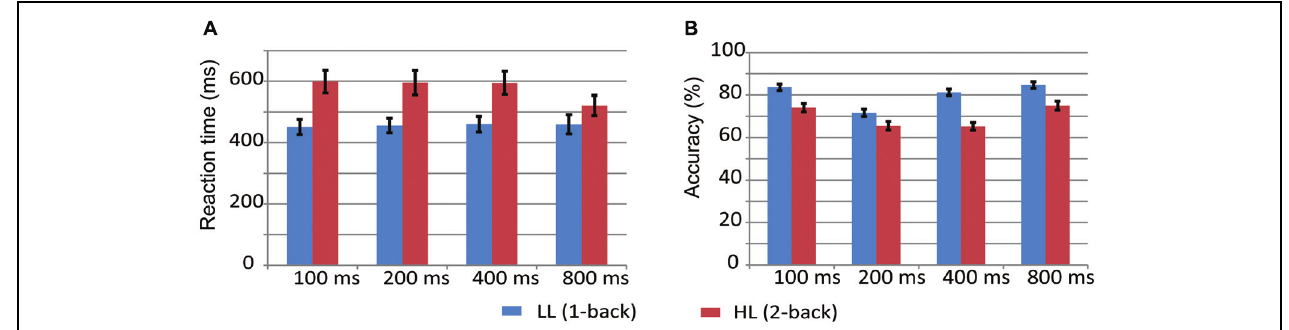
FIGURE 2 | Reaction time and accuracy in the LL (A, 1-back) and HL (B, 2-back)